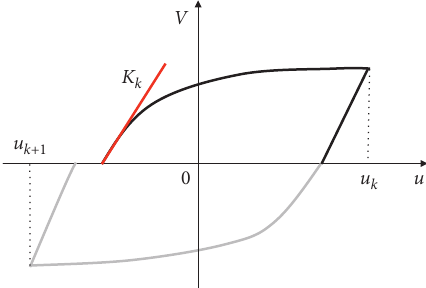
Figure 4: The initial loading stiffness of the k -th half-cycle.